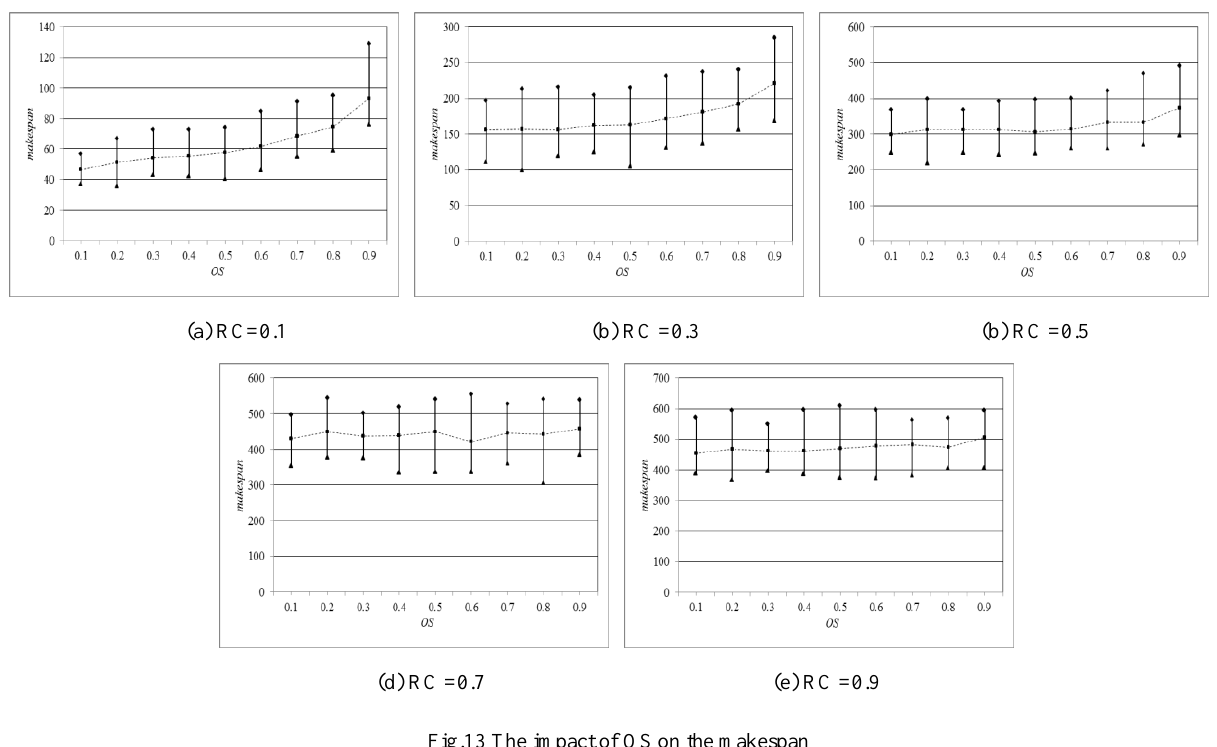
Fig.13 The impact of OS on the